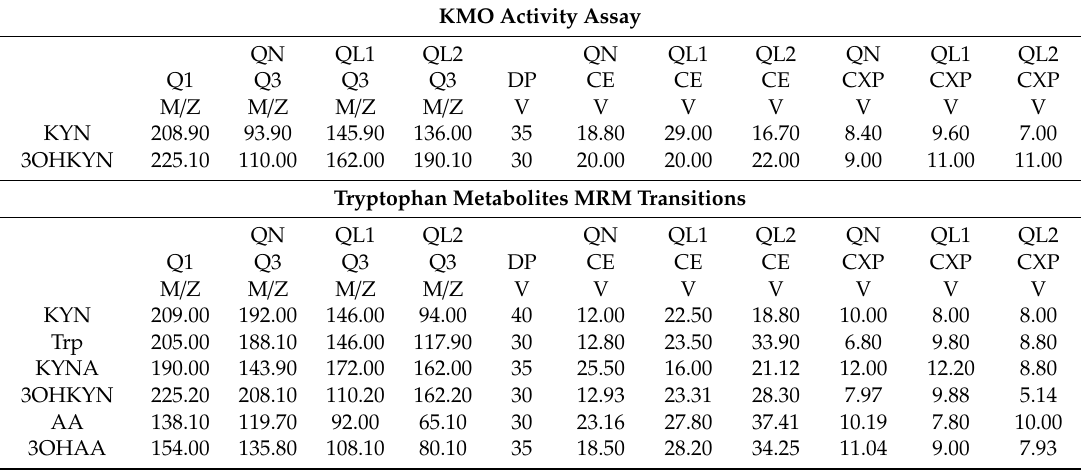
Table 1. The multiple reaction monitoring (MRM) transitions for observed